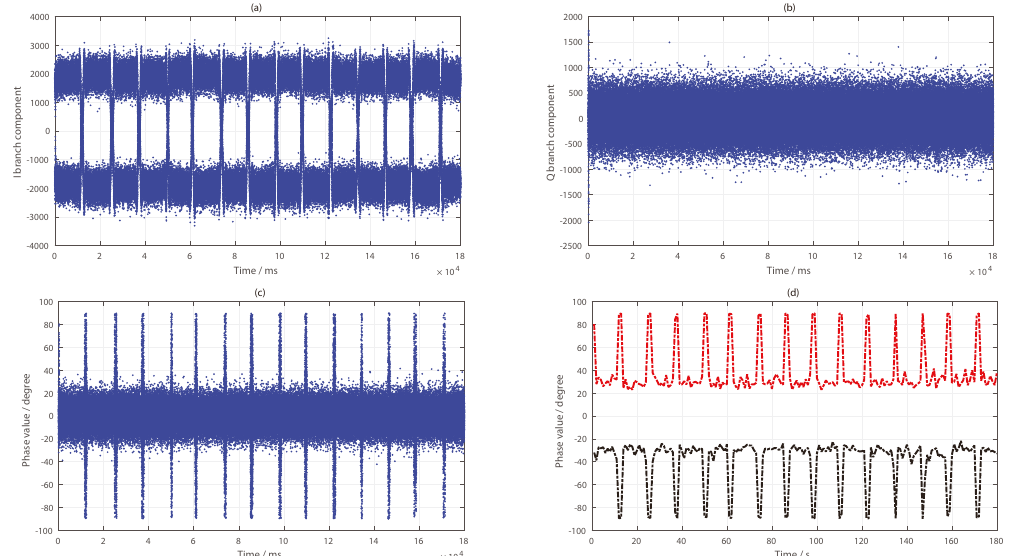
Figure 19. Results of the BeiDou PRN8 satellite reflected signal: ( a ) I branch component data; ( b ) Q branch component data; ( c ) phase difference information (in ms); ( d ) phase difference information (in